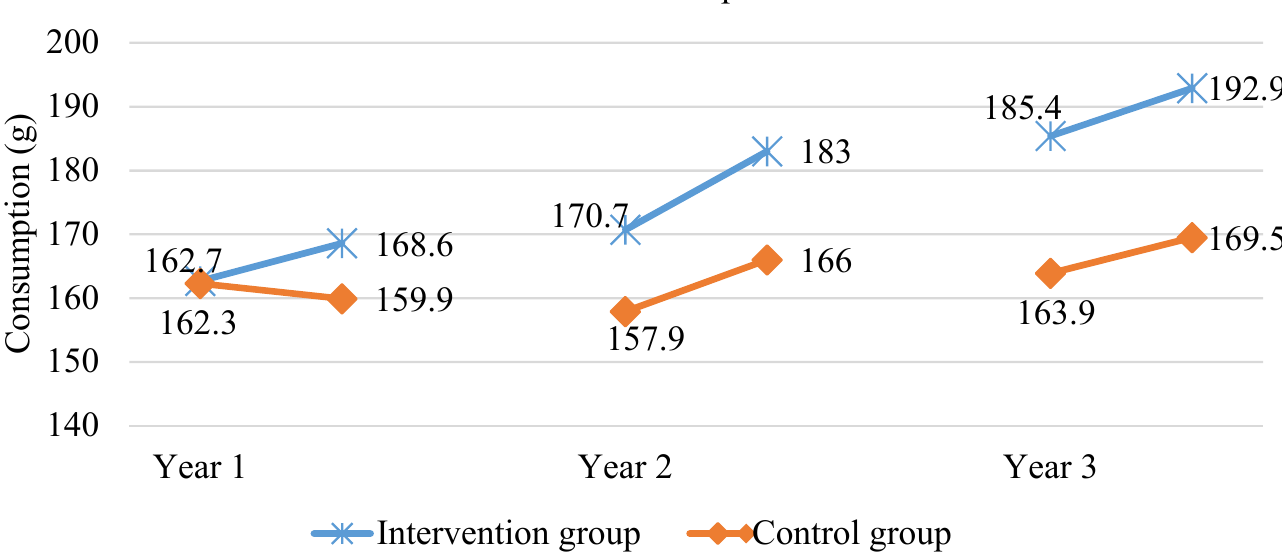
Figure 1. Fruit consumption (on both school and weekend days) during the three years of the study.